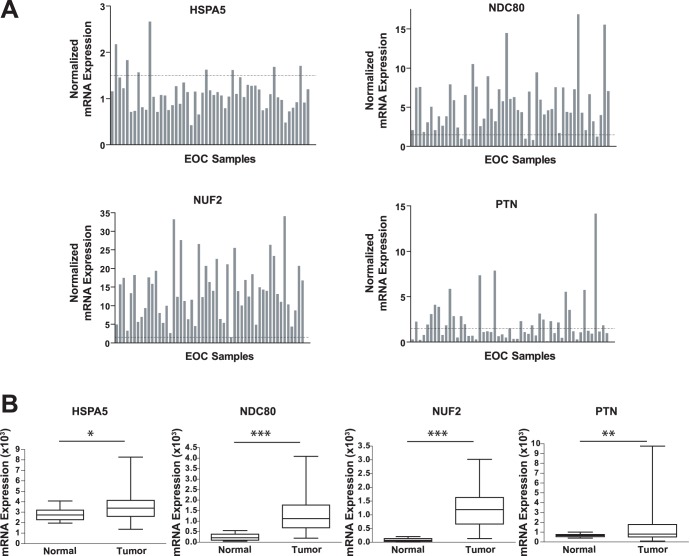
Assessment of clinical significance using an independent cohort.
A. Shown are the gene expression levels for 53 serous adenocarcinomas normalized to the mean gene expression levels measured in normal ovarian tissue (n = 10). B. Shown are the mean gene expression levels across the serous adenocarcinomas for NDC80, NUF2, PTN and HSPA5. A two-tailed t-test indicates that the increase in gene expression in the tumor samples is statistically significant relative to the normal tissue. *** = p<0.0005; ** = p<0.005; * = p<0.05.